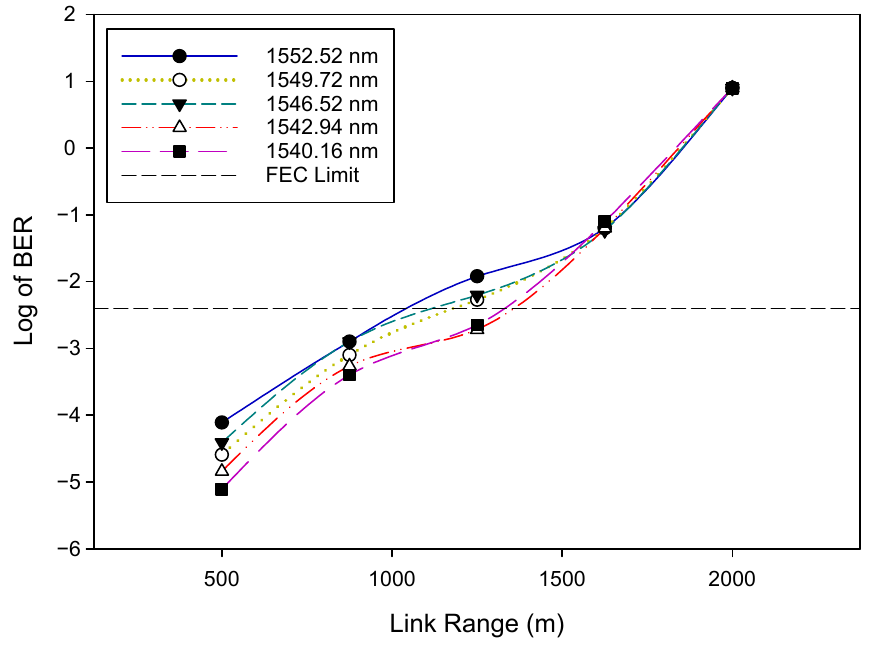
Figure 9. BER versus Link range plots for uplink. Table 3. Main RSOA